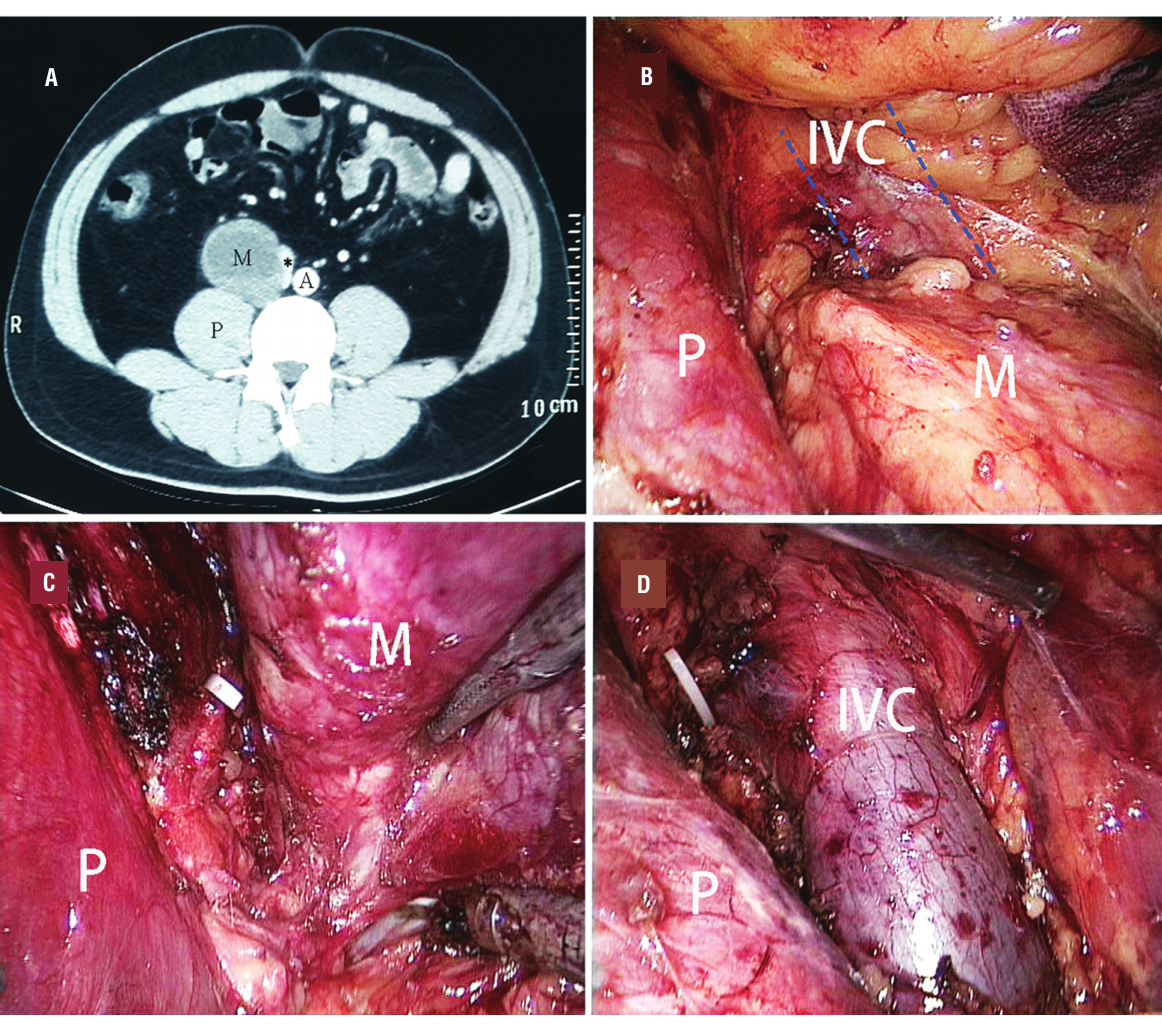
Figure 2 - Preoperative CT and intraoperative findings of patient 6. A) Preoperative CT scan image showing a large tumor located between the IvC (asterisk) and the psoas muscle. The IvC was compressed medially. B) The tumor was identified after entering the retroperitoneal space. It was located medially to the psoas muscle. The IvC was compressed medially to the tumor. C) Laparoscopic view during dissection. The IvC had been released from the media side of the tumor. D) Laparoscopic view after resecting the tumor. CT indicates computed tomography; A = aorta; IvC = inferior vena cava; M = mass; P = psoas